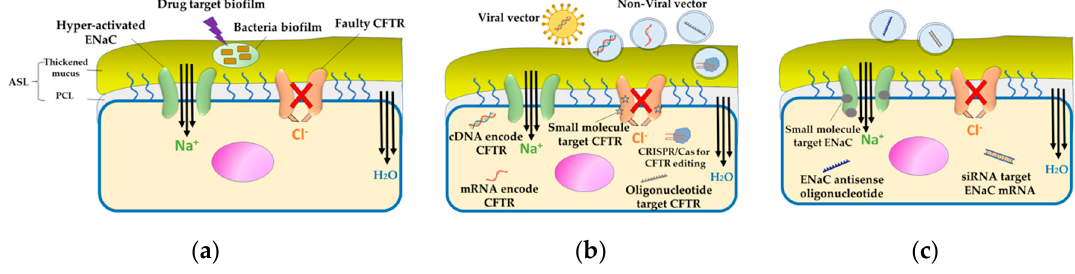
Figure 5. Therapeutic approaches for CF. ( a ) Targeting bacterial biofilm: Bacterial infection in CF is associated with the formation of a biofilm that resists the host immune system as well as antibiotics. Antibiofilm therapy is essential to prevent bacterial colonization and adherence. ( b ) Direct therapy for CFTR: Faulty CFTR is corrected by gene therapy, wherein CFTR is delivered as cDNA or mRNA using a viral or non-viral vector. Another approach is the use of antisense oligonucleotide molecules to repair the mRNA encoded CFTR. Small molecule modulators, like potentiator, stabilizer, corrector, and amplifier are considered as promising agents for the restoration of CFTR function. ( c ) Indirect therapy targeting the hyperactivated ENaC: In CF, owing to the loss of CFTR regulation, the sodium channel (ENaC) is hyperactivated, leading to the dehydration of the mucus layer. Inhibiting ENaC expression using siRNA, antisense oligonucleotide molecules, or small molecule modulators can correct the mucociliary defect.